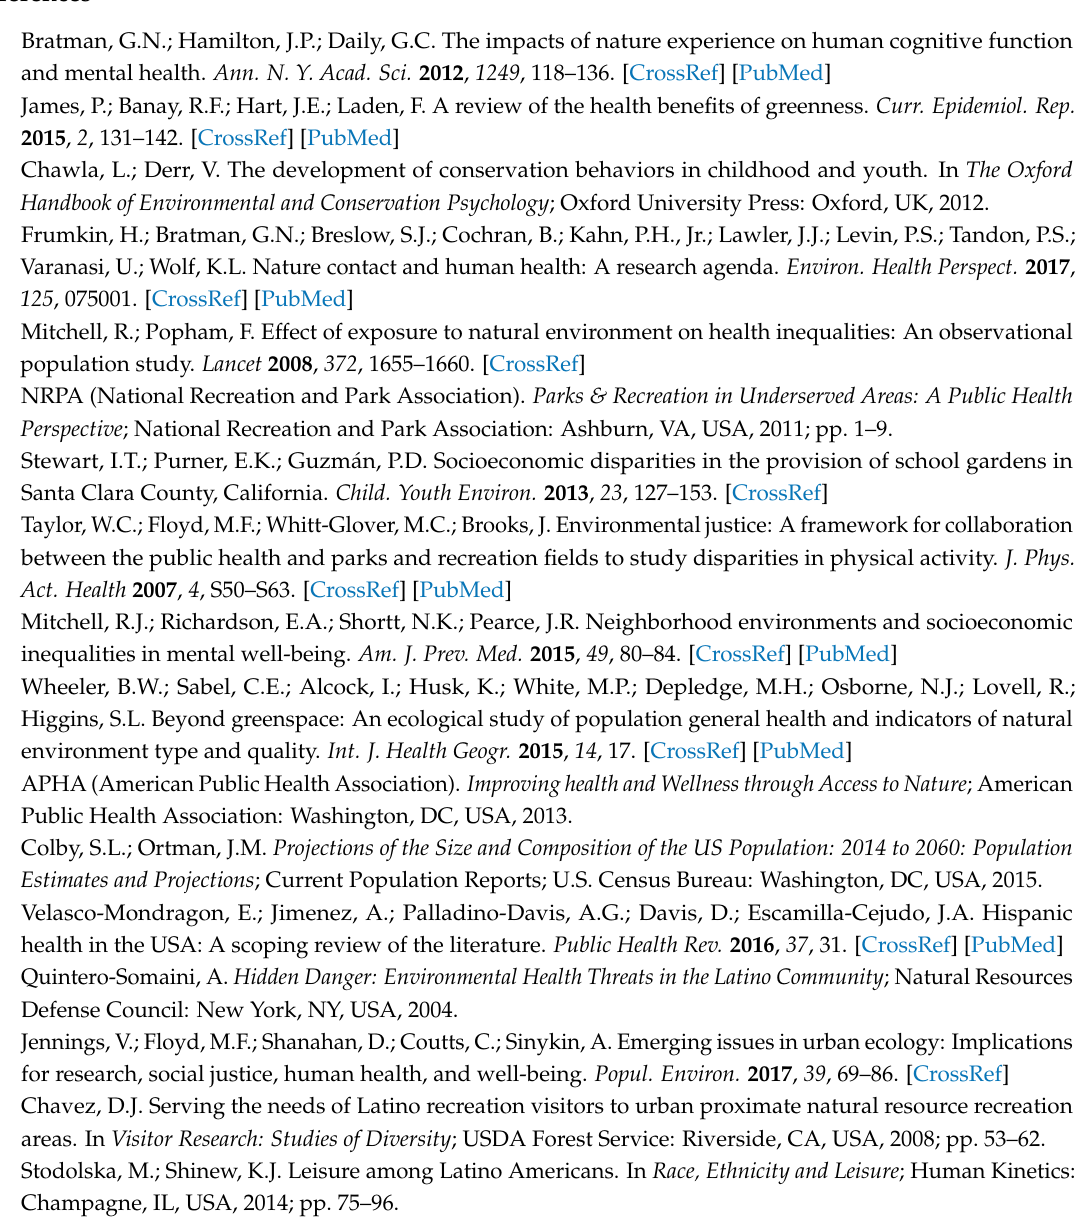
Table S1: Peer-reviewed and grey literature documents ( n = 108) that met the final criteria for inclusion in this review (i.e., reported primary research data related to some aspect of nature experience for Latino populations in the United States). The positive reporting of each document on six broad research themes (Table 1) used in the analysis is shown using a